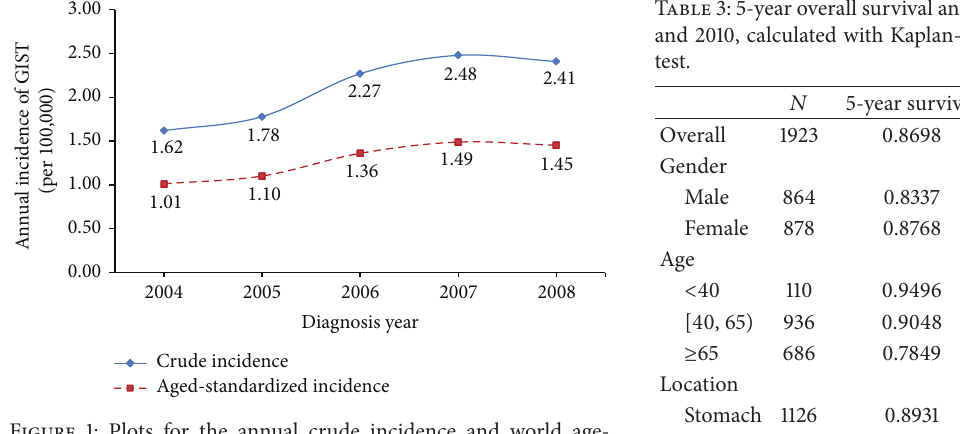
Figure 1: Plots for the annual crude incidence and world age- standardized incidence of GISTs between 2004 and 2008 (per 100,000). Table 1: Annual crude incidence of GISTs between 2004 and 2008 (per 100,000).